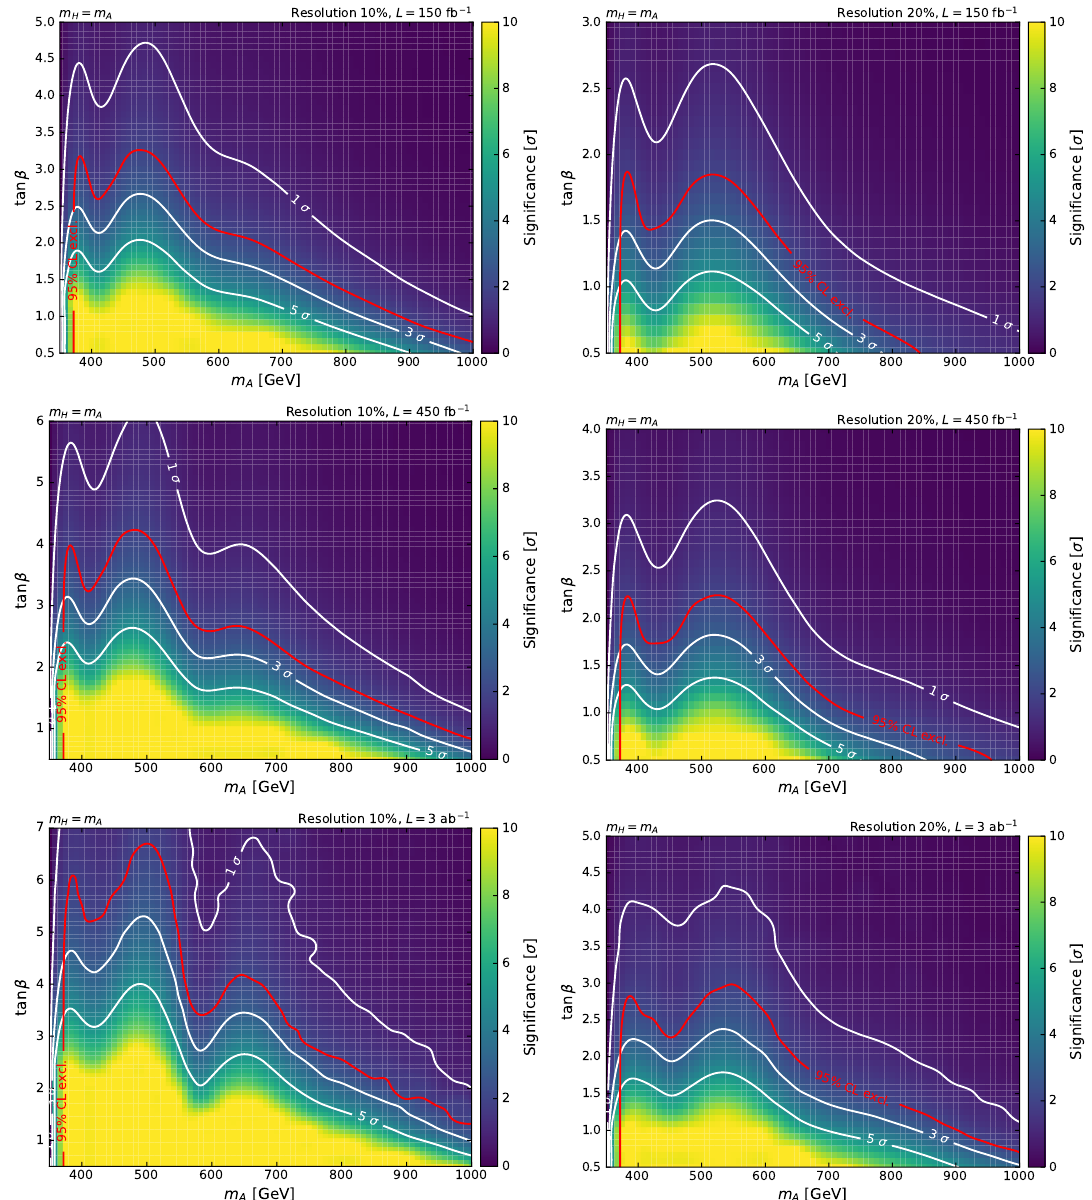
Figure 11 . Expected signi(cid:12)cance and exclusion potential for a Type II 2HDM assuming the mass degeneracy M H = M A in the same six experimental scenarios as considered in (cid:12)gure 10. Values of signi(cid:12)cance in excess of 10 (cid:27) are clipped. A resolution of 10% and 20% is assumed for the left- and the right-hand side plots,